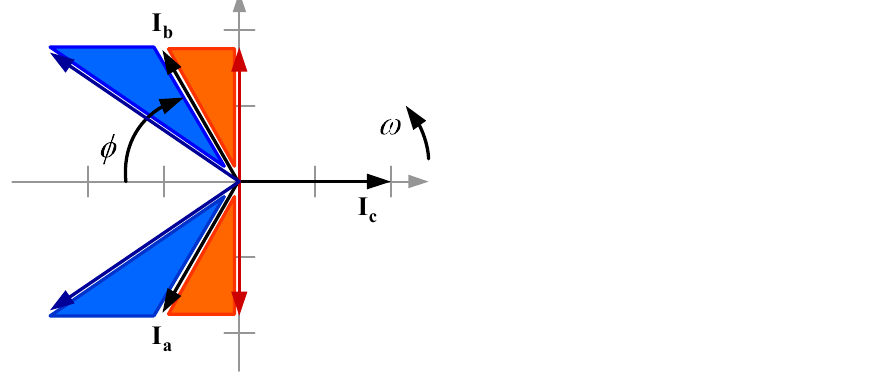
Figure 4. Phase currents I a and I b shifting range when a faulty condition occurs in phase current I c . In Figure 4, the red zone denotes the varying sectors for I a and I b magnitudes and phase angles when the I c amplitude drops until reaching zero ( I c = 0). Under this condition, I a and I b go through these regions until setting on the opposite phase to each other, over the vertical axis; hence, phase current I a goes 30 ◦ forwards, whereas phase current I b